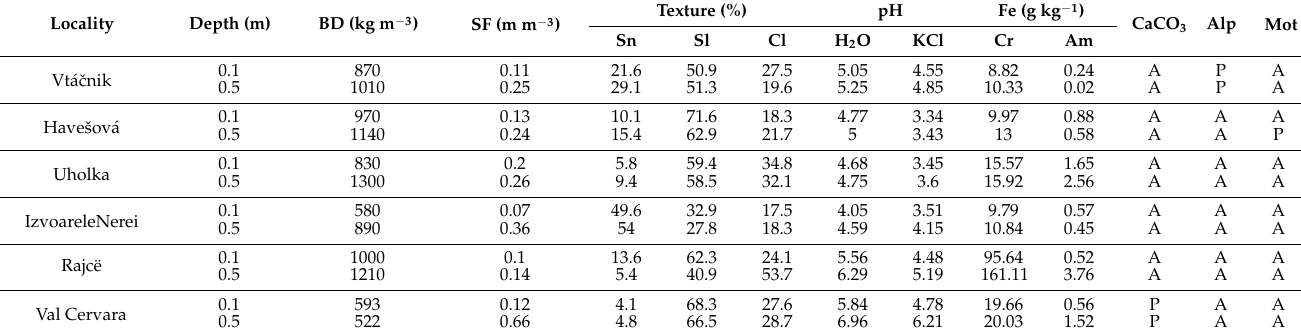
Table 3. Soil physical and chemical properties. Abbreviations: BD—bulk density, SF—stony fraction, Alp—allophane, Mot— mottling, P—presence, A—absence, Sn—sand, Sl—silt, Cl—clay, Cr—crystalline Fe oxides, Am—amorphous Fe